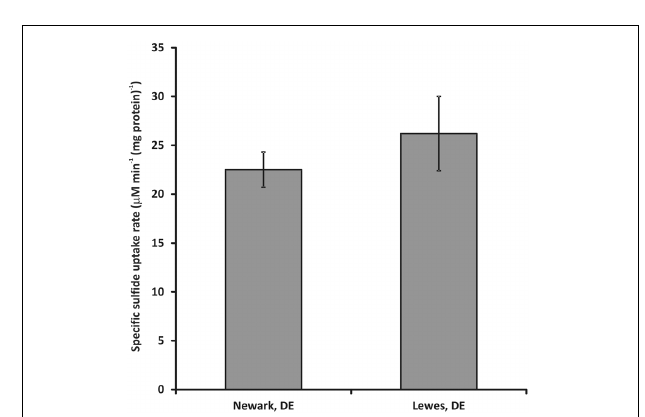
FIGURE 4 | Inter-laboratory comparison of sulfide uptake rates for washed cell suspensions of C. tepidum . Sulfide uptake rates were assayed at 50–60 µ M initial HS- concentration at 5 µ Ei m − 2 s − 1 PAR flux with a biomass concentration of 5 ( µ g protein) ml − 1 . Error bars represent the standard error of the data set ( n = 10 for Lewes, DE and 27 for Newark,